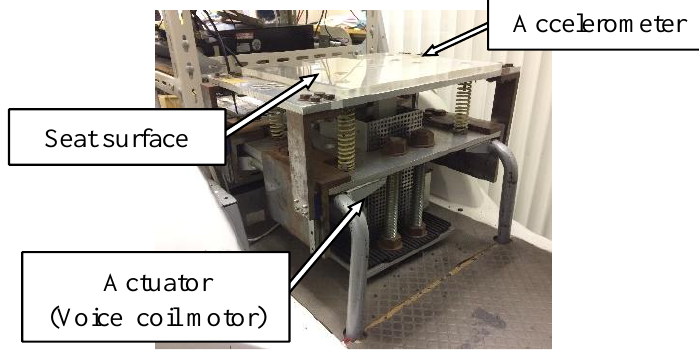
Figure 7. Photograph of active seat suspension.